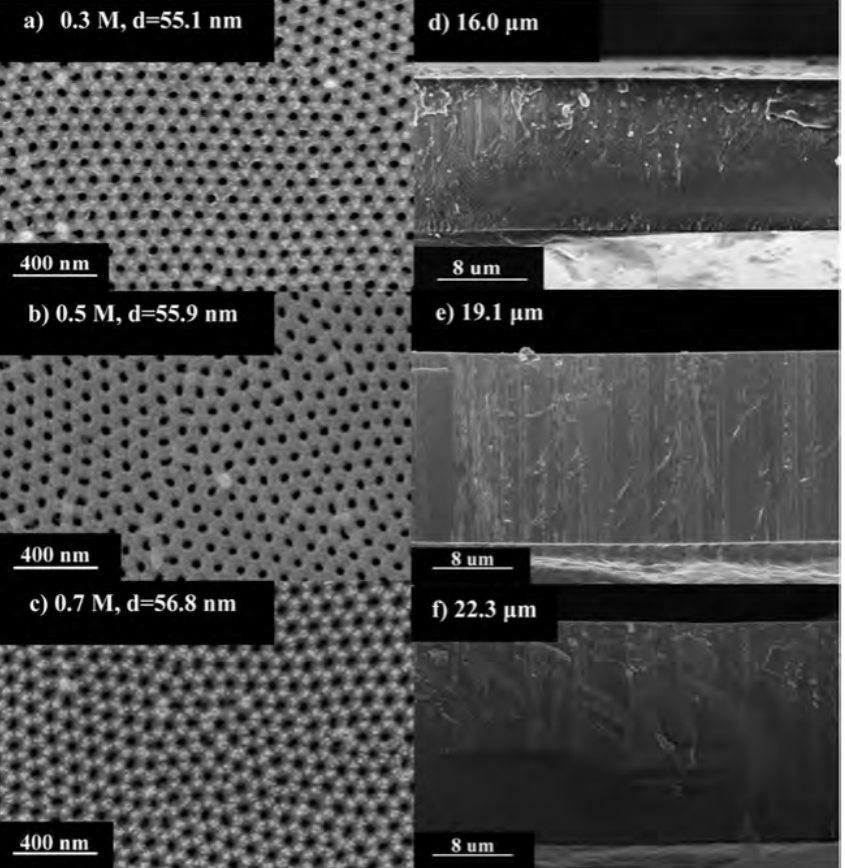
Figure 7. SEM micrographs of the top views and cross sections of the AAO membranes formed through two-step anodization at 40V and 25 °C for 1 h in the oxalic acid solution with concentrations: ( a , d ) 0.3 M; ( b , e ) 0.5 M; and ( c , f ) 0.7 M [62].